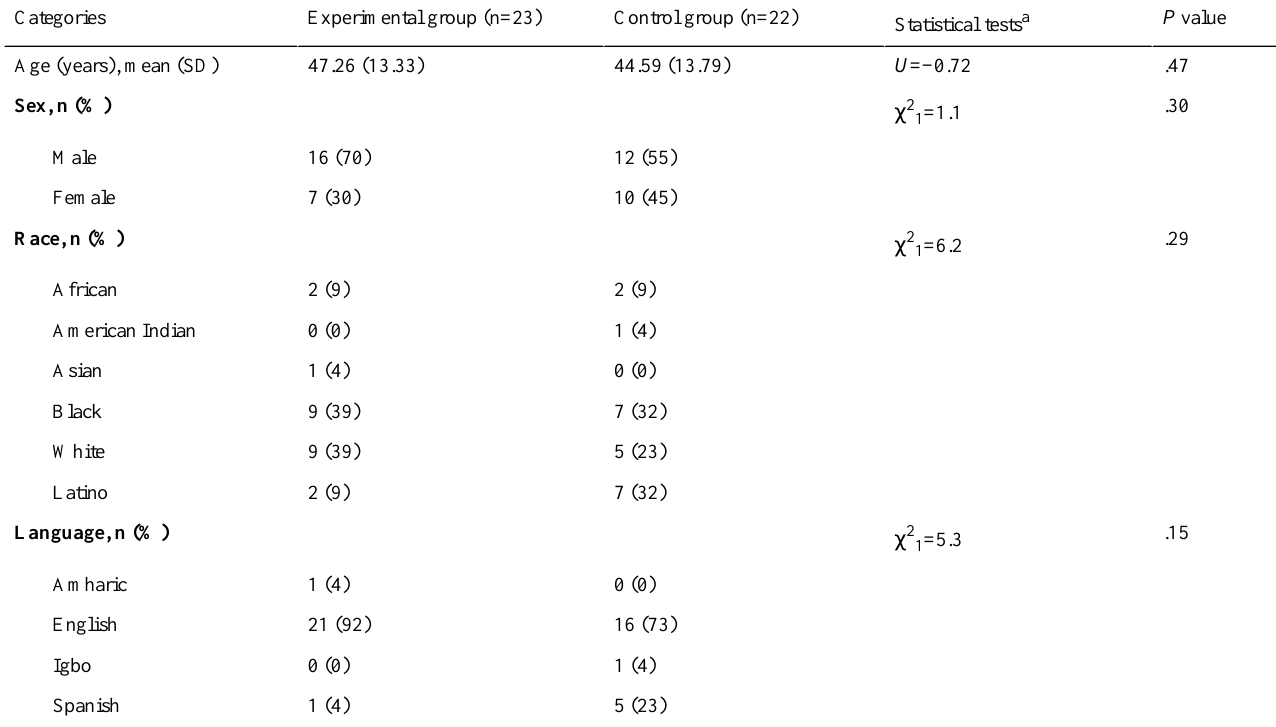
Table 1. Demographic data of the participants per allocated group